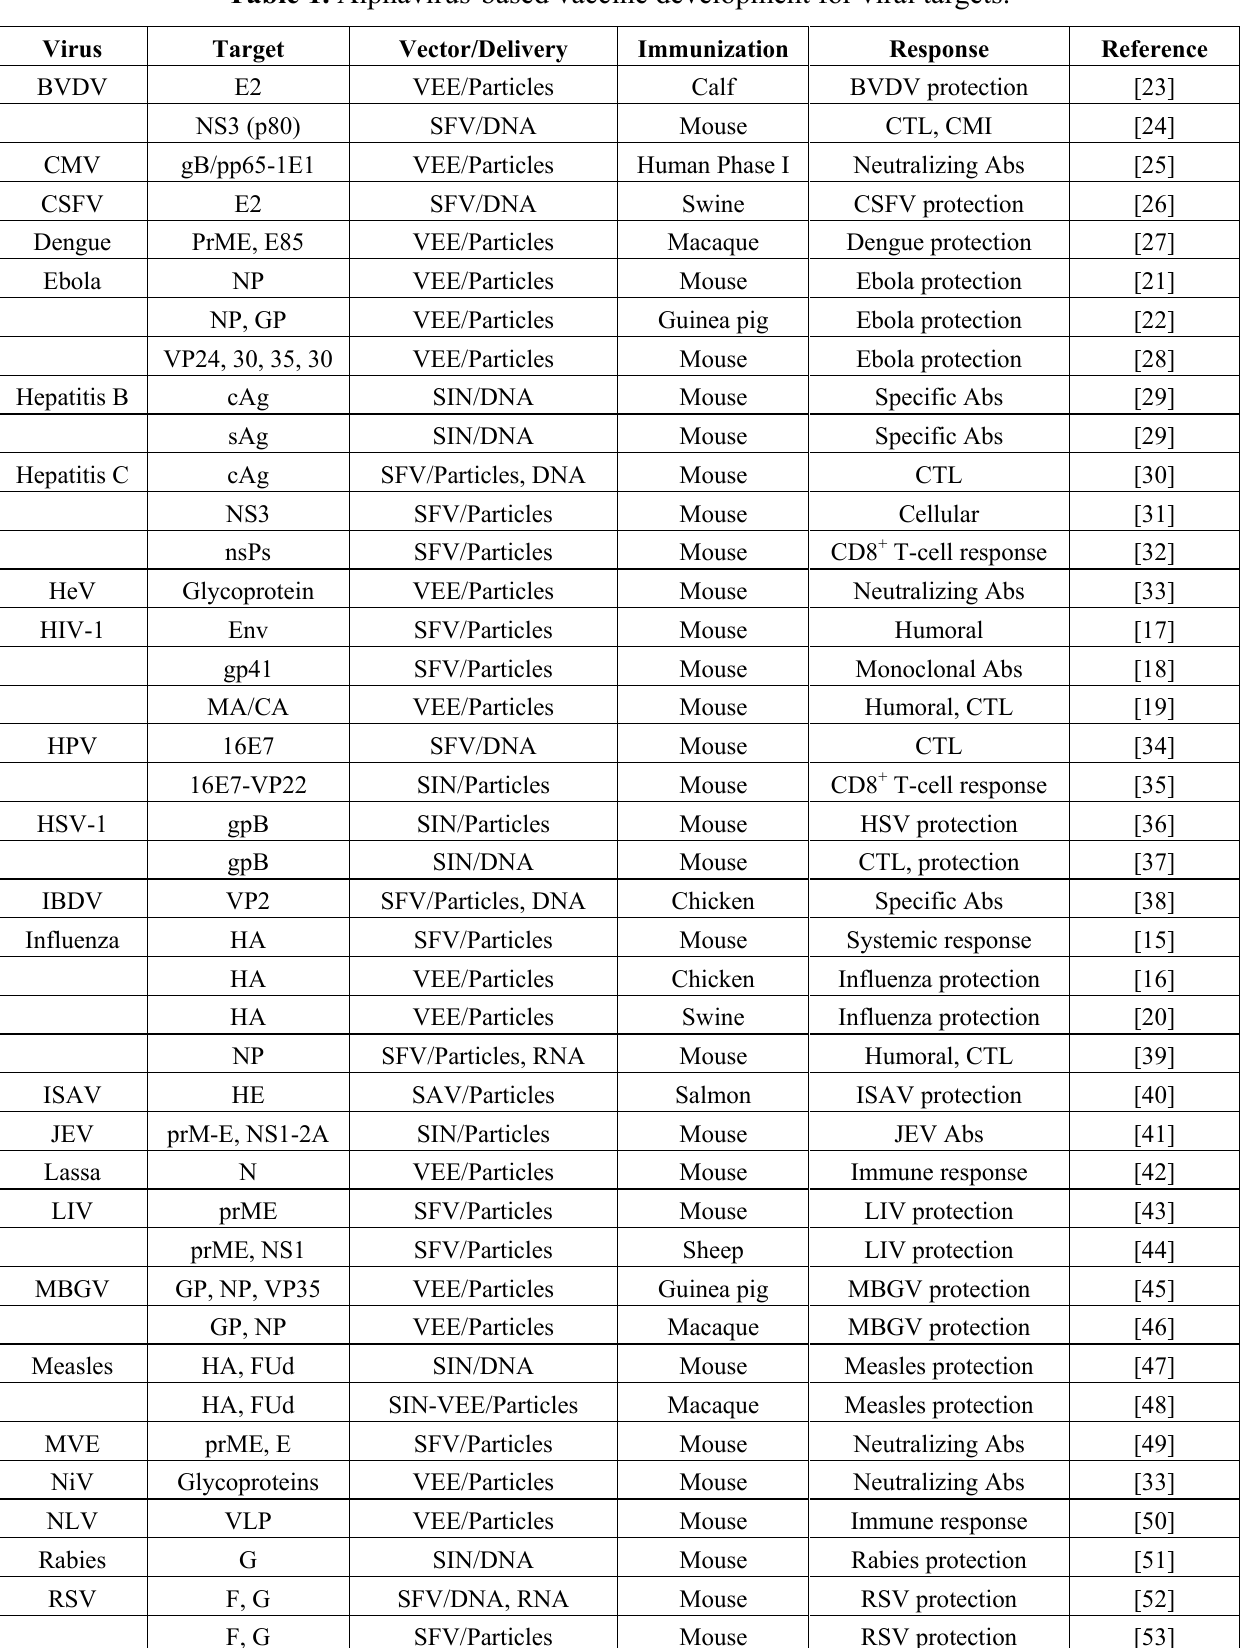
Table 1. Alphavirus-based vaccine development for viral